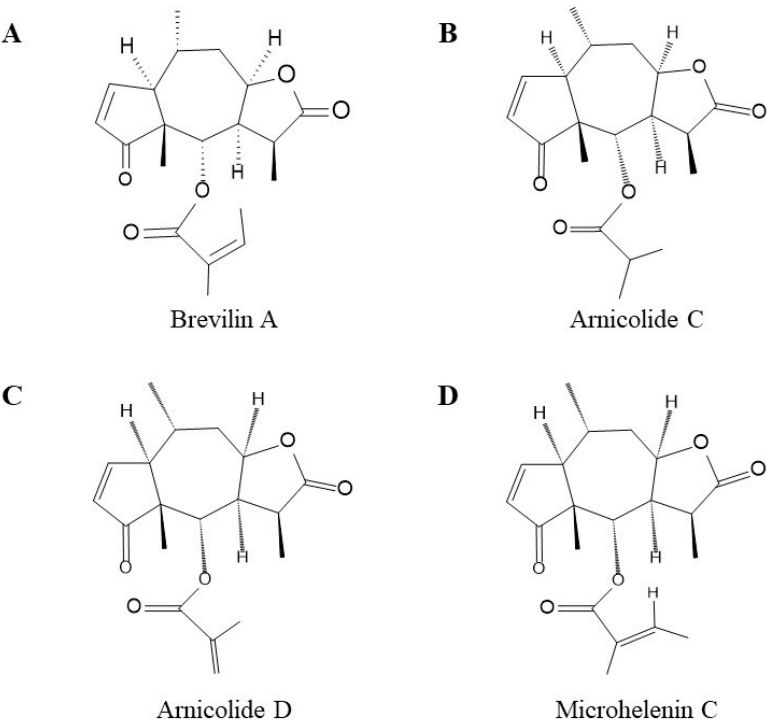
Figure 1. Chemical structure of CMX components. ( A ) Brevilin A. ( B ) Arnicolide C. ( C ) Arnicolide D. ( D ) Microhelenin C.